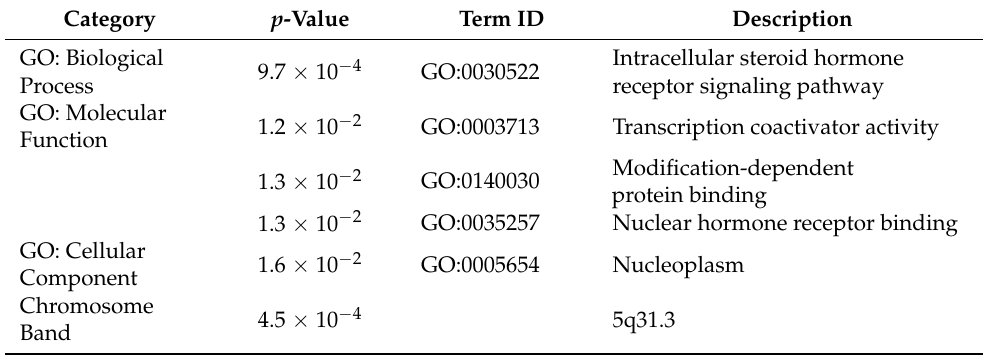
Table 12. Selected top gene term enrichments of the coexpressed genes to NR3C1 in